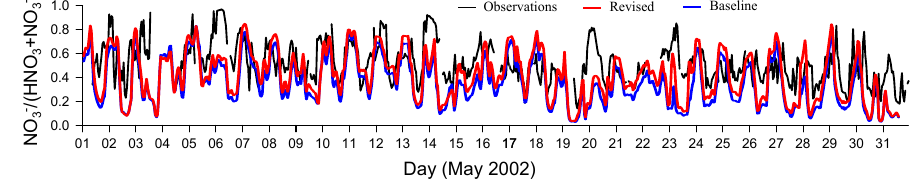
/ (HNO 3 + N − ) ] at the Sydney, FL, site 3 3